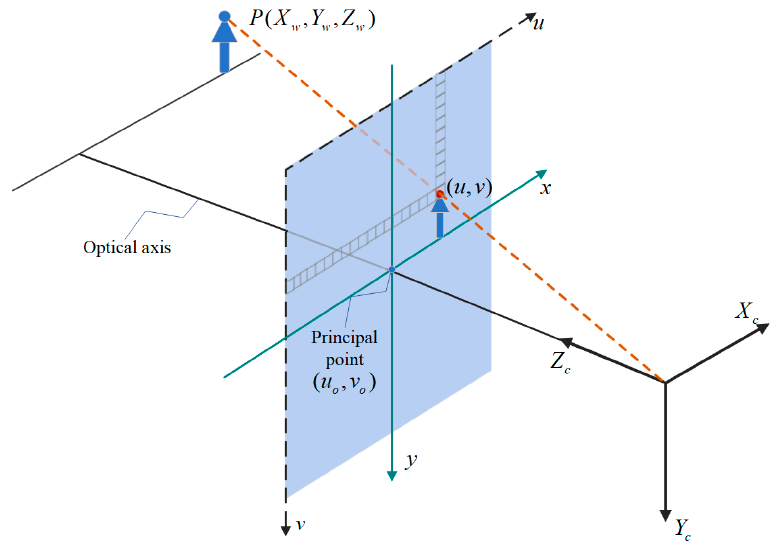
Figure 7. The imaging geometric model of the camera.